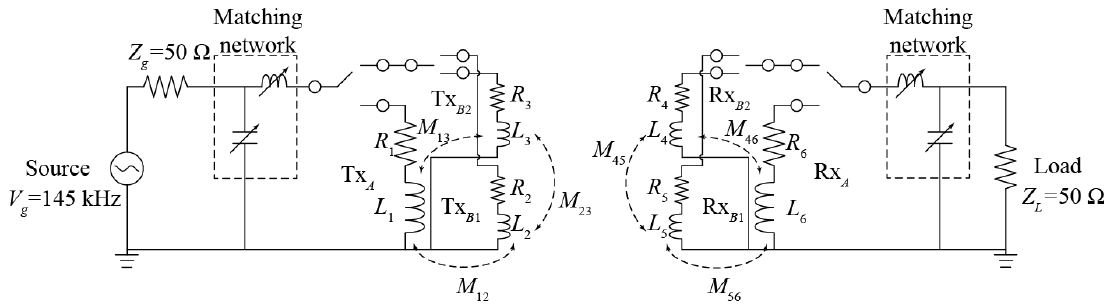
Figure 2. Equivalent circuit of a symmetric wireless power transfer (WPT) system based on 2 × 1 multilayer